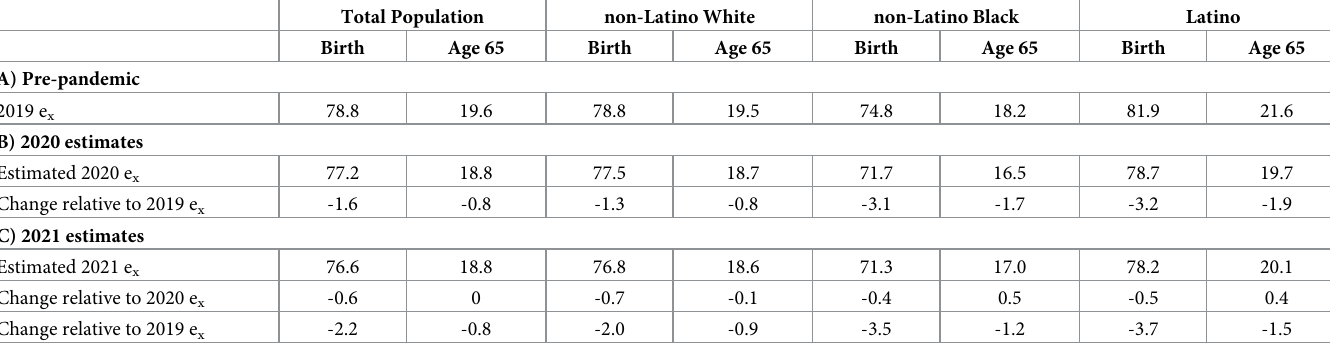
Table 1. Life expectancy estimates and changes (in years) from 2019 for the total US population and by race/ethnicity.